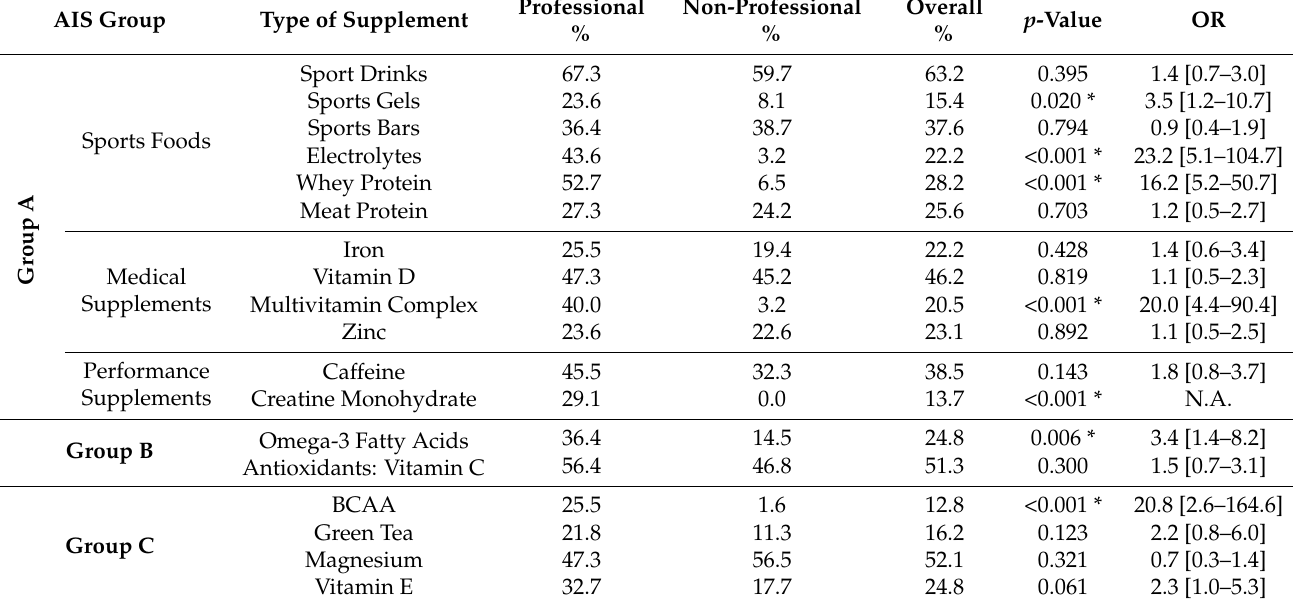
Table 3. DS most consumed by competition level according to AIS classification